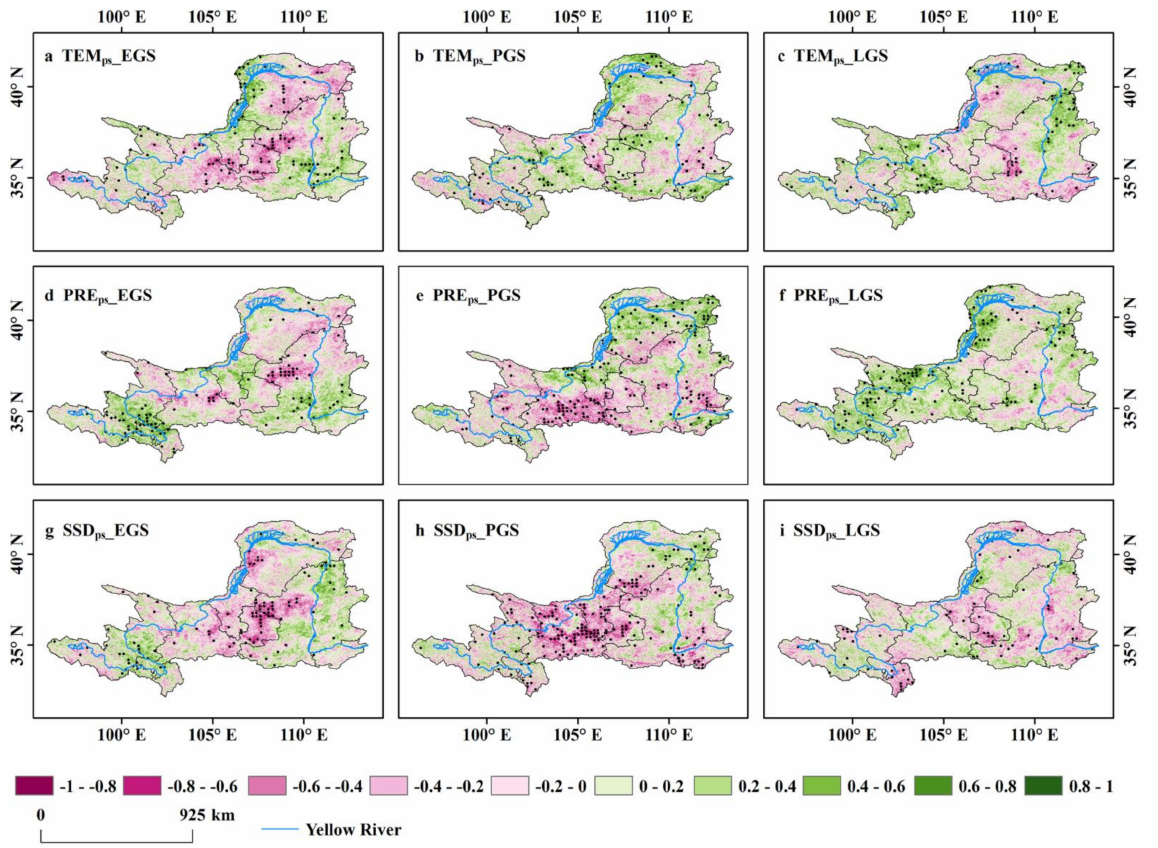
Figure 6. Spatial distribution of the partial correlations between NDVI of each season and climate factors of the preceding season. Correlation patterns are shown for EGS ( a , d , g ), PGS ( b , e , h ), and LGS ( c , f , i ), and for correlation with TEM ps ( a – c ), PRE ps ( d – f ), and SSD ps ( g – i